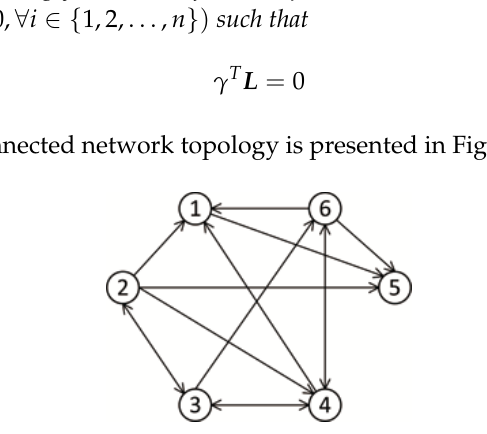
Figure 1. The topology of a strongly connected